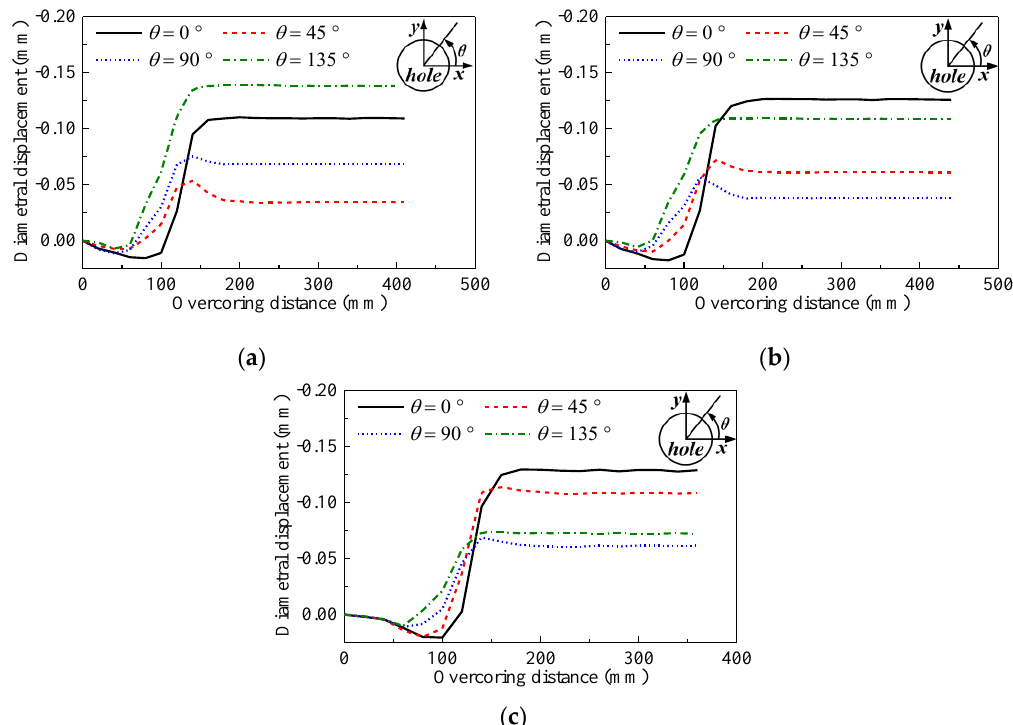
Figure 14. Overcoring test curves. ( a ) #1 borehole; ( b ) #2 borehole; ( c ) #3 borehole.